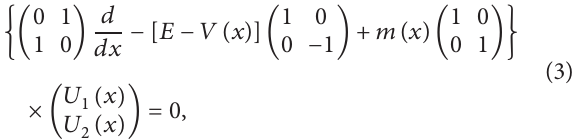
Figure 1: The different values of the GAWSp. (a) shows 𝑉 0 = 1 , 𝑎 = 5 , 𝑏 = 5 , 𝑝 = 1 , ̃𝑝 = 1 , 𝐿 = 2 , and ̃𝑞 = 1 , 𝑎 = 2 , 𝑏 = 2 , 𝐿 = 2 , and ̃𝐿 = 2 (dash-dotted lines). (b) shows 𝑉 = 1 , 𝑞 = 1 , ̃𝑞 = 1 , 𝑎 = 5 , 𝑏 = 5 , 𝑝 = 1 , and ̃𝑝 = 1 (dash-dotted 𝑉 0